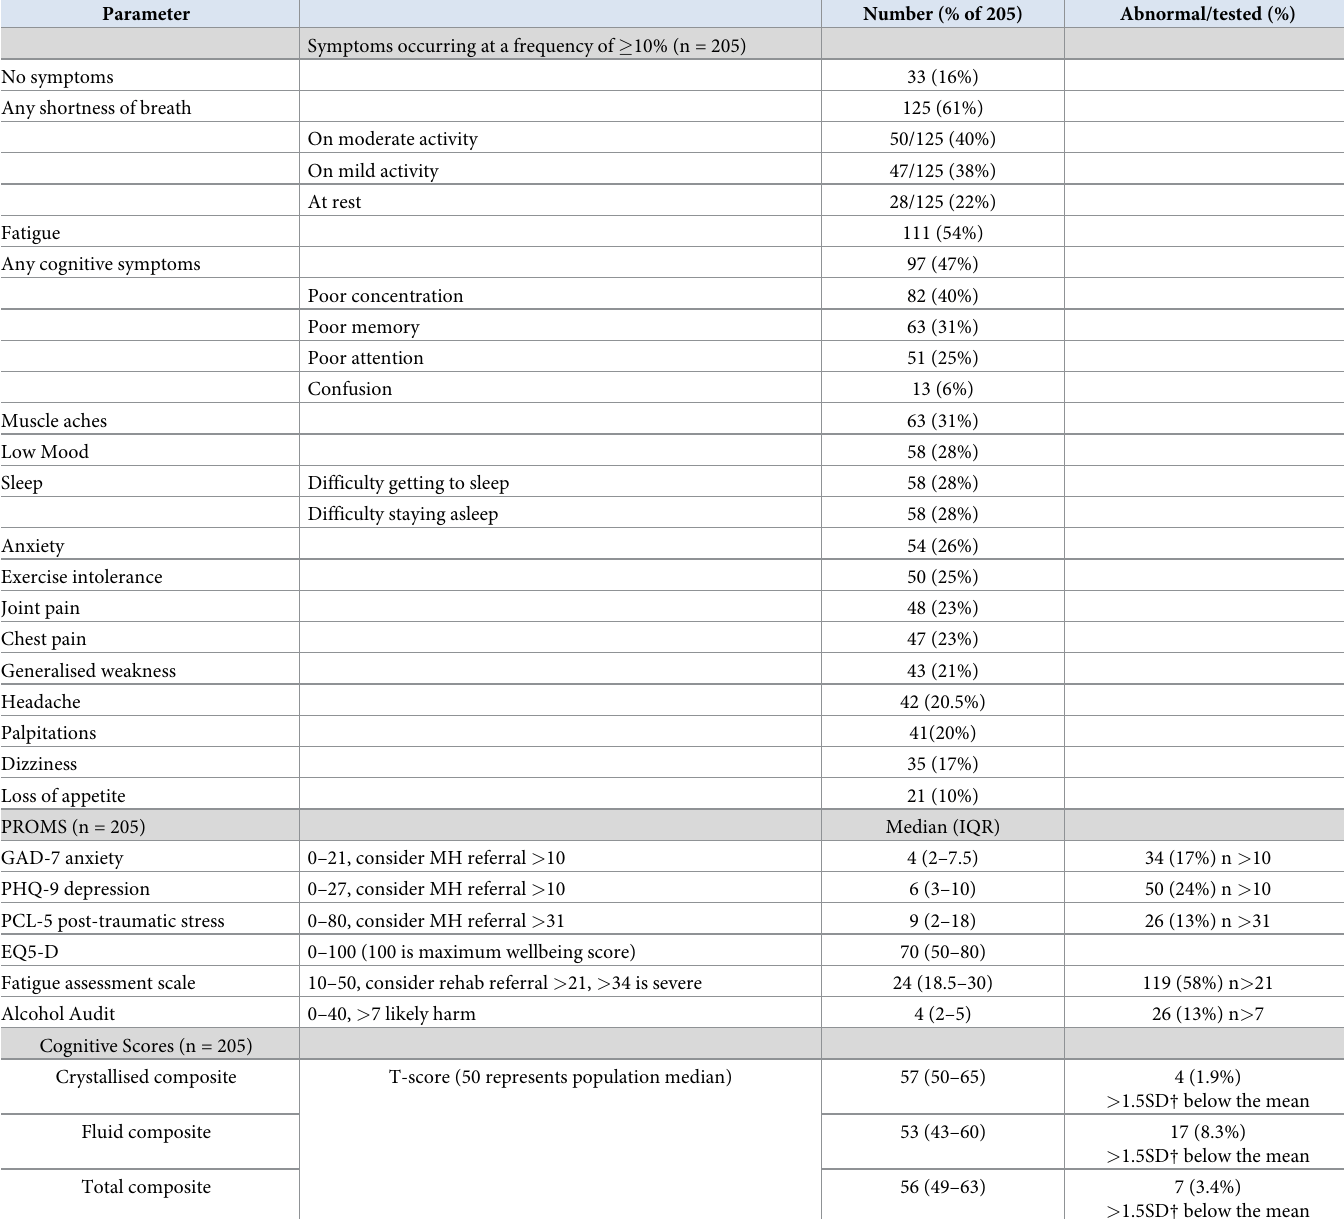
Table 4. Symptoms, Patient Reported Outcome Measures (PROMS) and cognitive scores. Parameter Number (% of